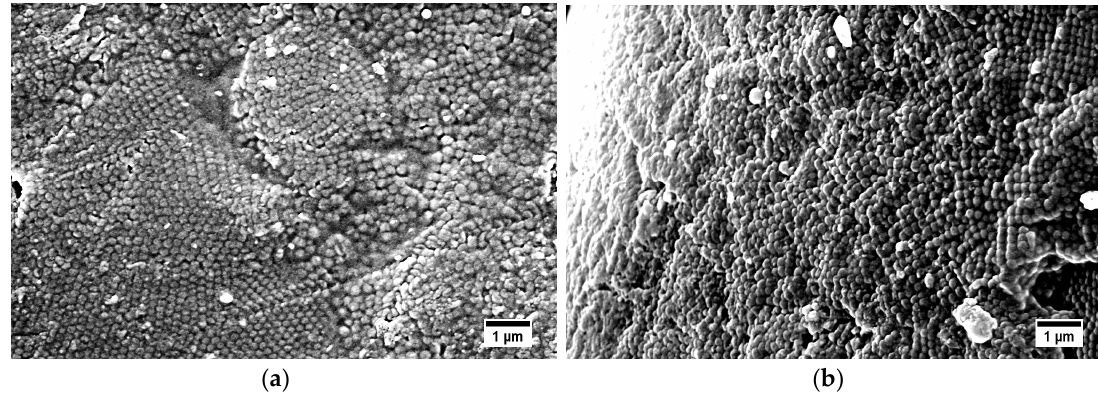
Figure 10. SEM images of the surface ( a ) and cross-section ( b ) of the P(S- co -ALMA)@P(EA- co -MPSEt) film after processing at 140 °C. The scale bars correspond to 1 µm.